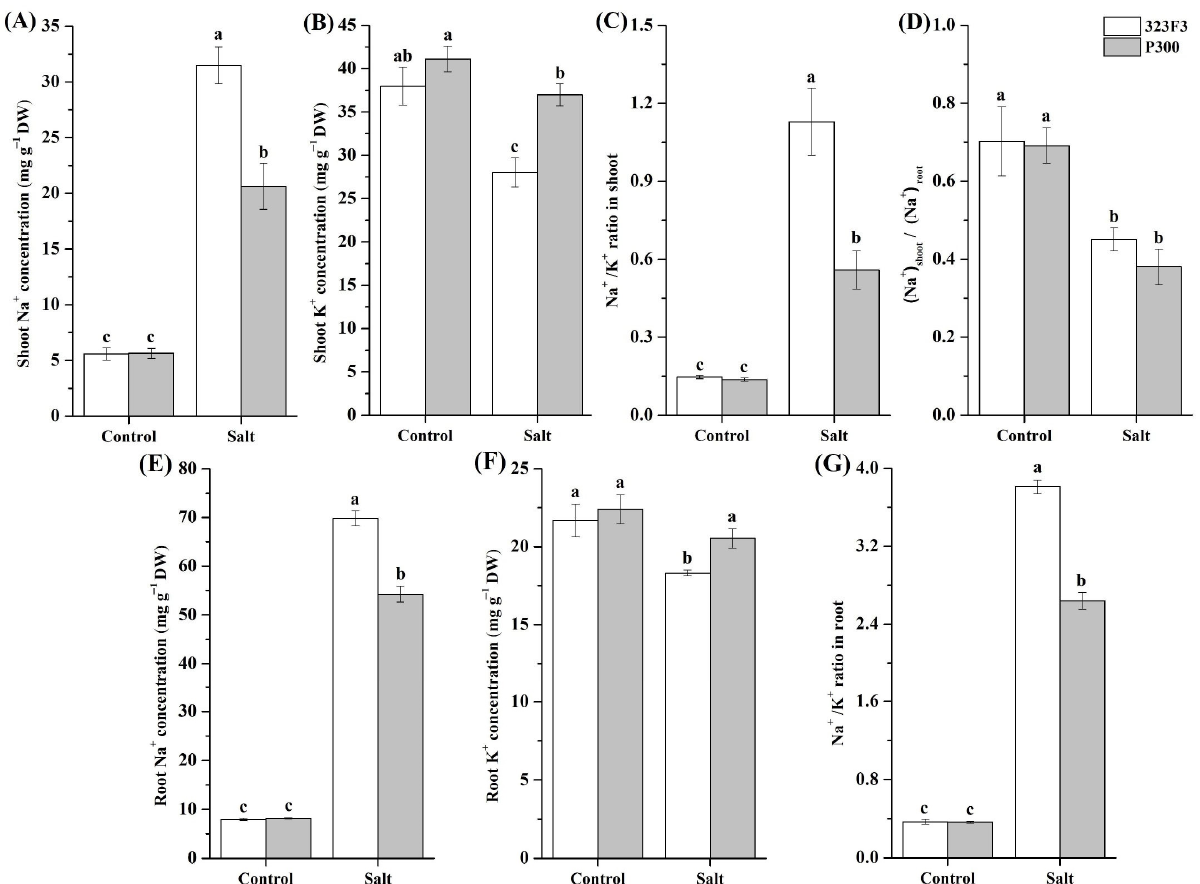
Figure 2. Shoot and root Na + and K + concentrations and Na + /K + ratio in 323F3 and P300 under control and salt treatment conditions. Each bar represents three biological replicates ± SD. Different small letters represent significant differences at p < 0.05 according to one ‐ way ANOVA. ( A – C ) Na + and K + concentrations and Na + /K + ratio in the shoots of 323F3 and P300. ( D ) The ratio of Na + concentration in shoots and roots. ( E – G ) Na + and K + concentrations and Na + /K + ratio in the roots of 323F3 and P300.